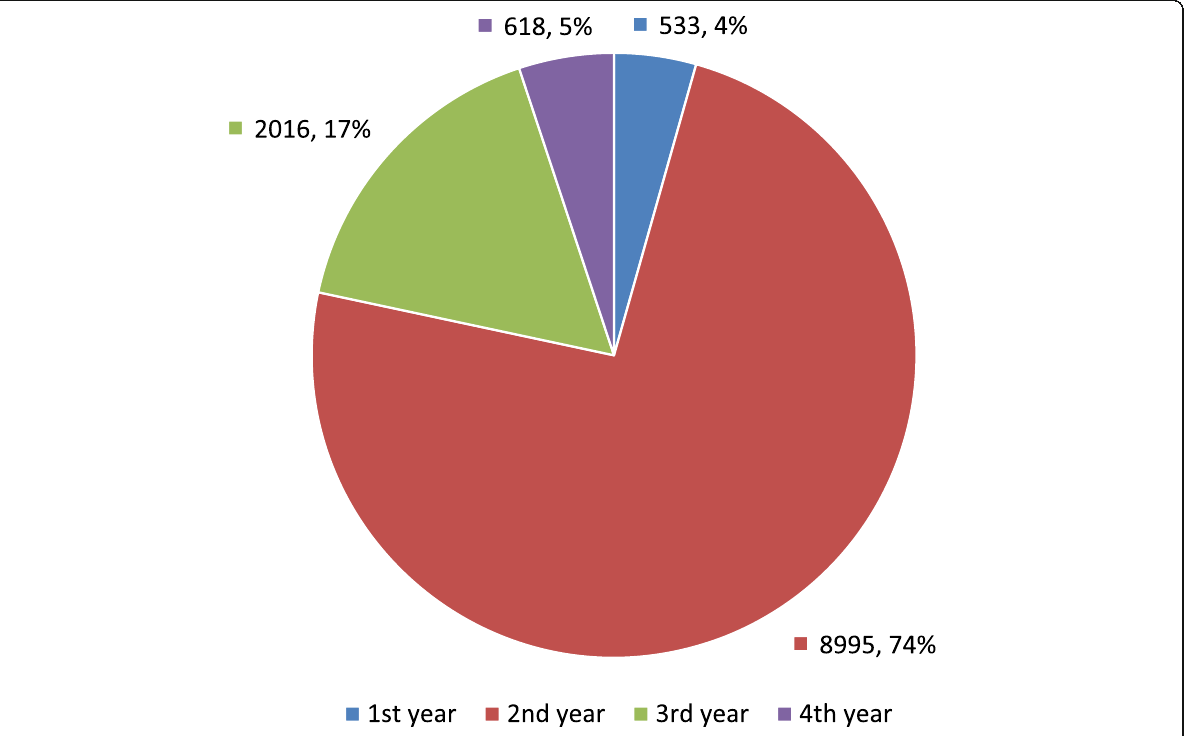
Fig. 2 Pie chart showing the distribution of evaluations by year of